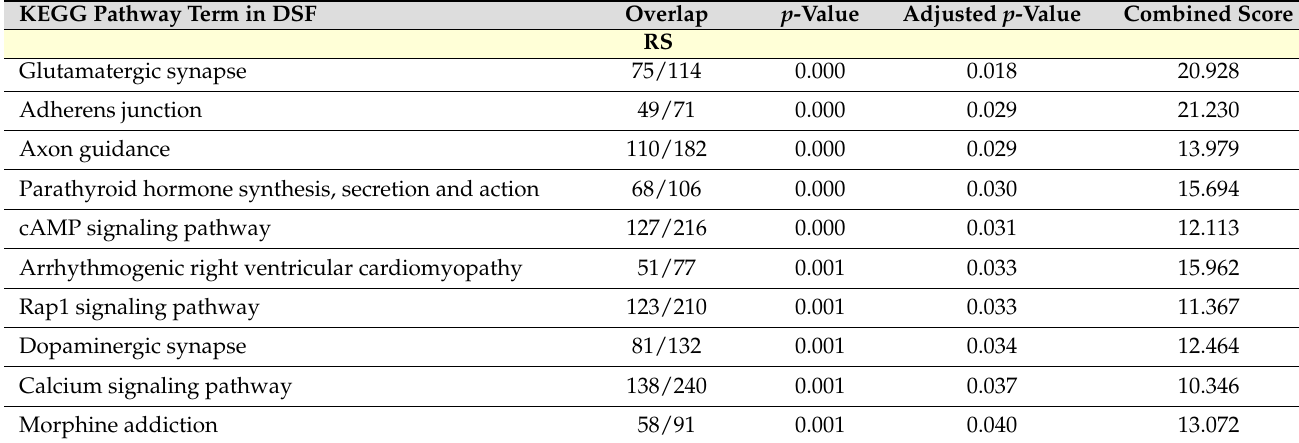
Table 4. Results of pathway enrichment analysis for DSF after replicative senescence (RS). Only the terms for which adjusted p -value reached the statistical significance level of 0.05 are listed. Overlap column indicates ratio between number of genes provided as input list and present in a particular pathway and the total number of genes constituting that pathway. p -value and adjusted p -value are calculated with Fisher’s exact test. Combined score is computed by taking the logarithm of the p -value from Fisher’s exact test and multiplying that by the z-score of the deviation from the expected rank. Rank-based ranking is derived from running the Fisher’s exact test for many random gene sets in order to compute a mean rank and standard deviation from the expected rank for each term in the gene-set library and finally calculating a z-score to assess the deviation from the expected rank.